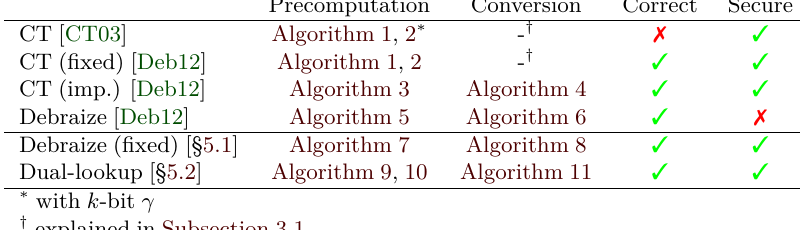
Table 1: Overview of the different table-based A2B